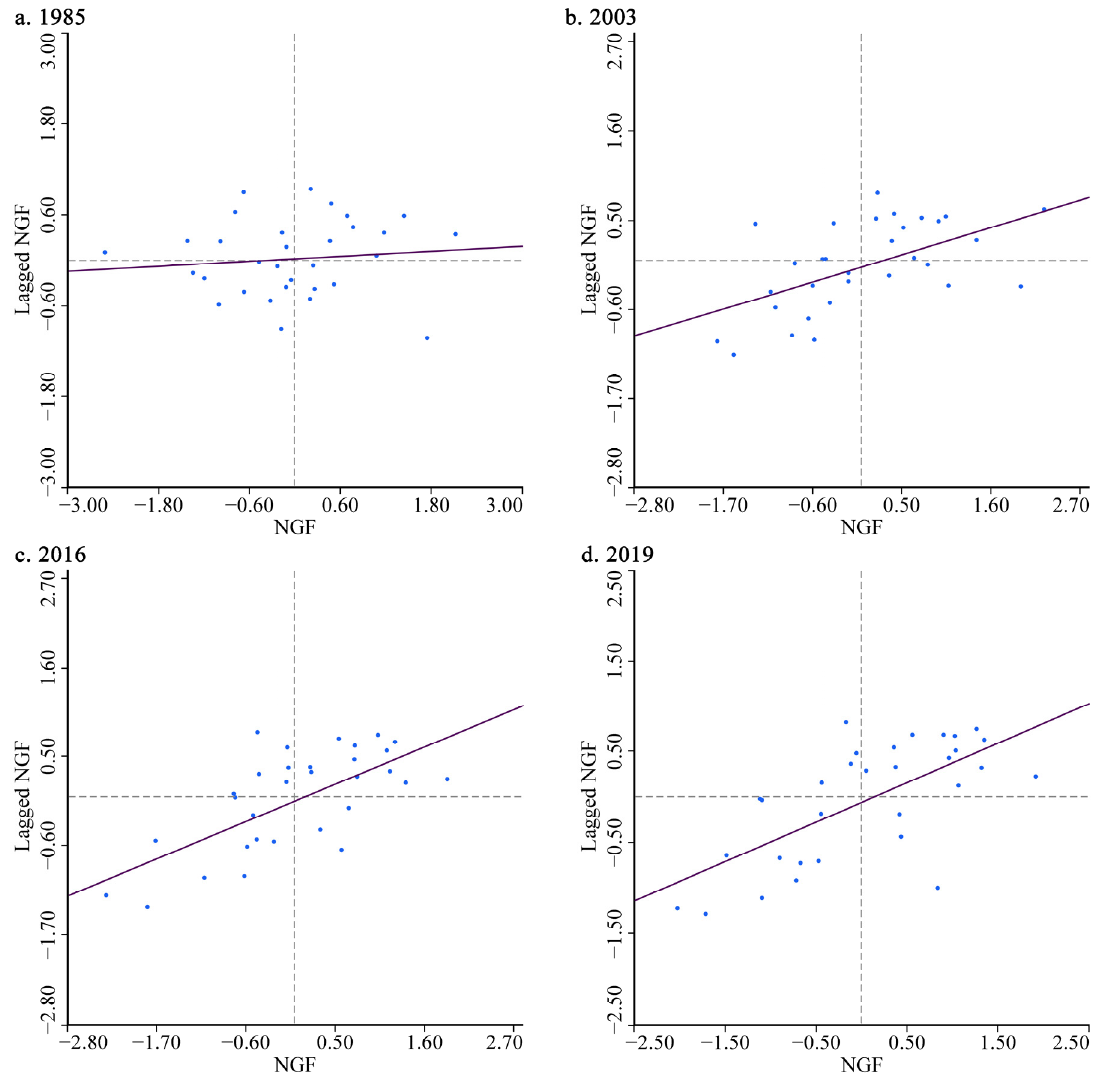
Figure 4. Moran scatter plot of NGF in China in 1985, 2003, 2016, and 2019 ( a – d ).